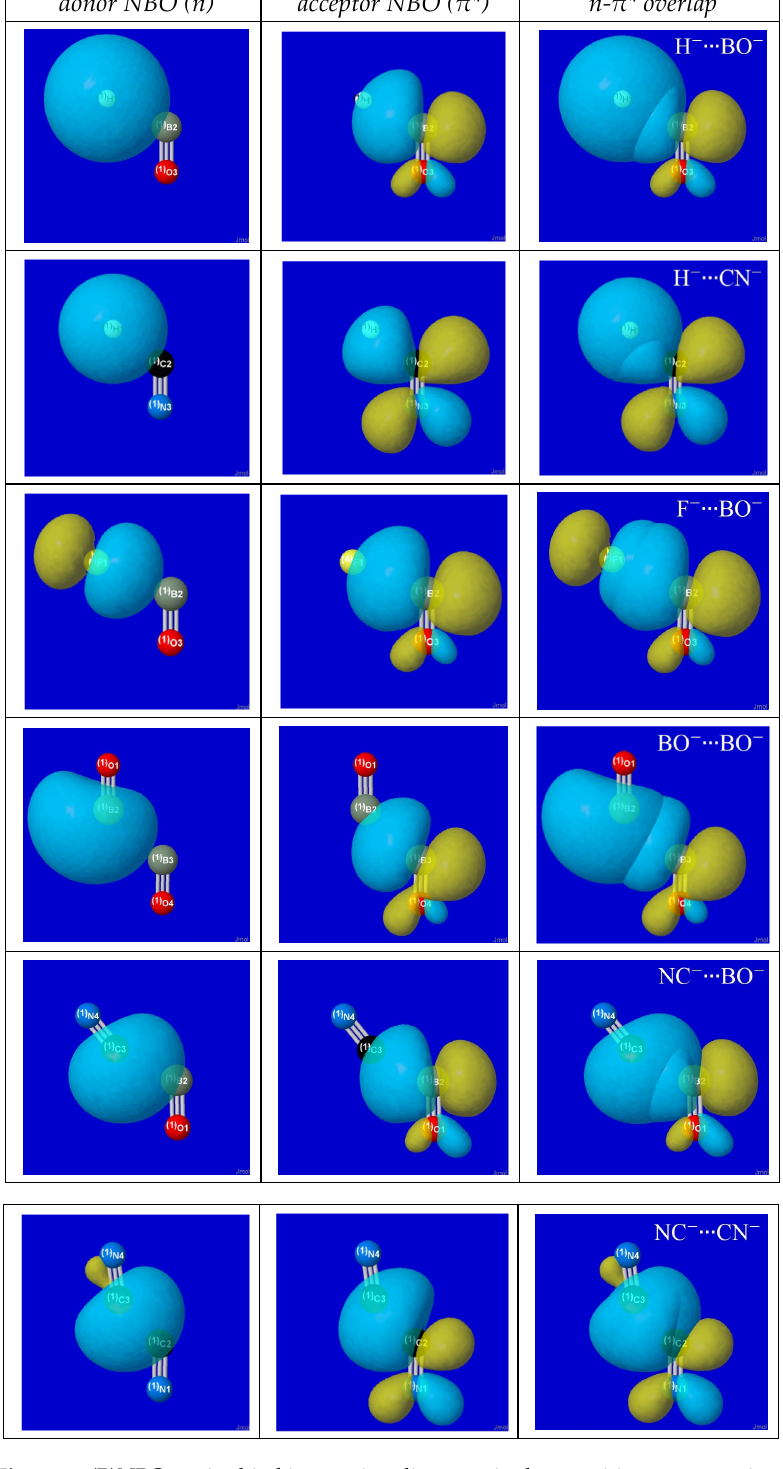
Figure 2. (P)NBO n - π * orbital interaction diagrams in the transition-state species of Figure 1, showing donor lone pair ( n , left ), acceptor antibond ( π *, center ), and intermolecular n π * overlap ( right ) that is maximized in Bürgi–Dunitz approach geometry.